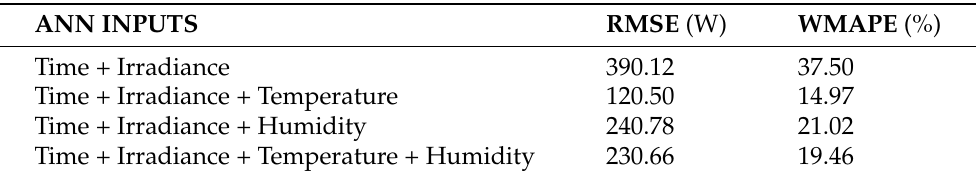
Table 2. Weighted Mean Absolute Percentage Error mean (WMAPE) and Root Mean Square Error (RMSE) for different inputs combinations.